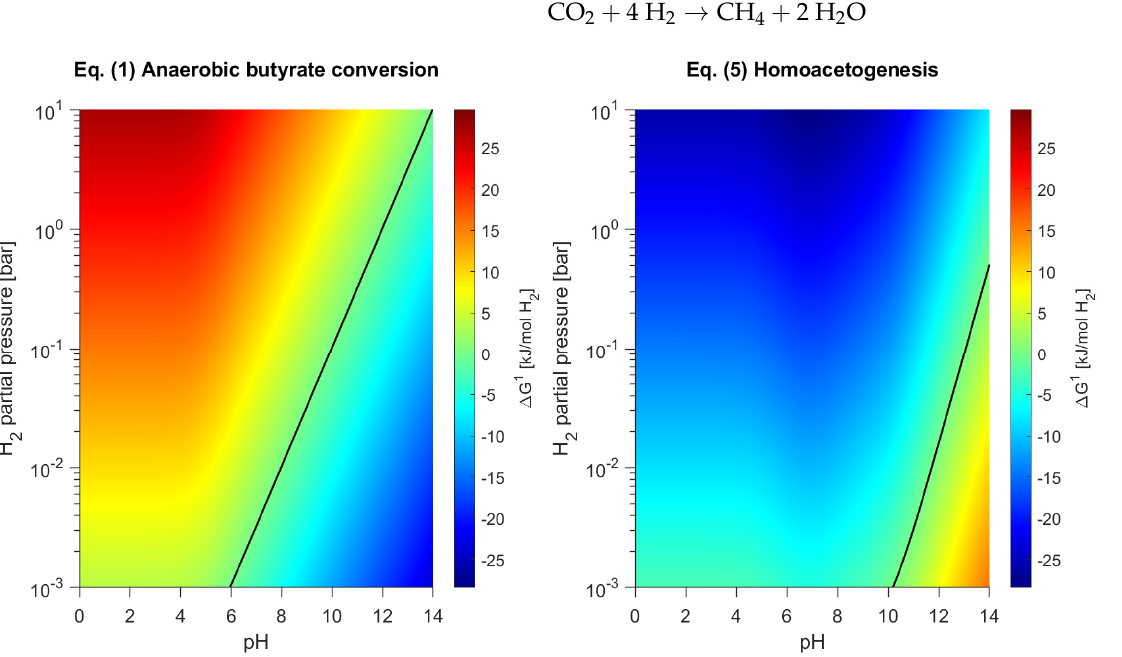
Figure 3. Actual Gibbs energy changes for acetate formation from butyrate (Equation (1)) and homoacetogenesis (Equation (5)) at 50 mM butyrate and 10 mM acetate. For the homoacetogenic reaction, the partial pressure of carbon dioxide was calculated according to Equations (S1)–(S20) in the Supplementary Material. Black line represents 0 kJ mol − 1 H 2 limit.